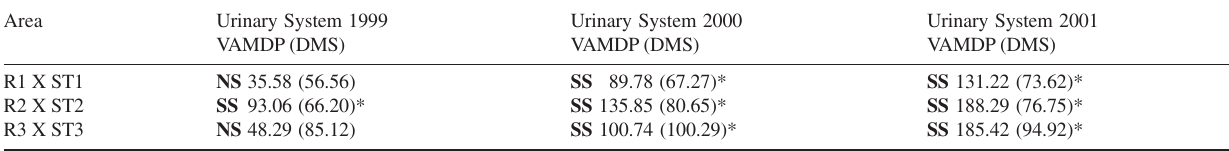
Table 9 – Comparative analysis of average correct answers in urinary imaging in 1999-2001 (*P<